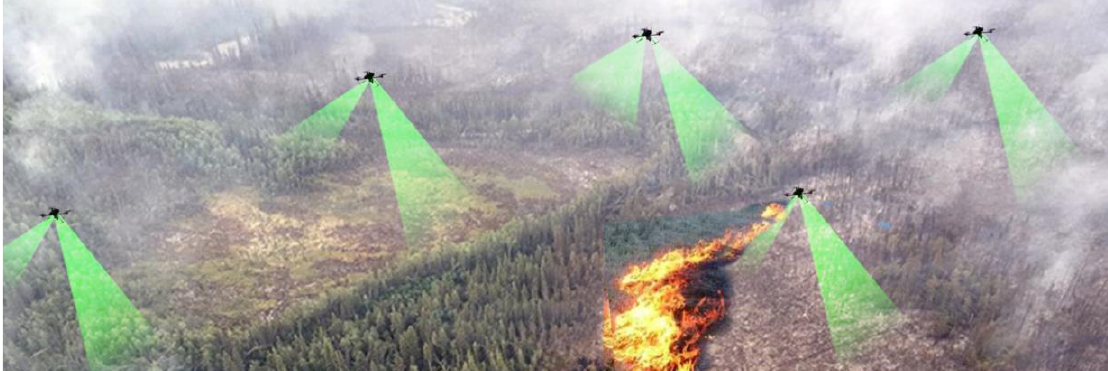
Figure 2. An example of UAVs collaborating for forest monitoring.